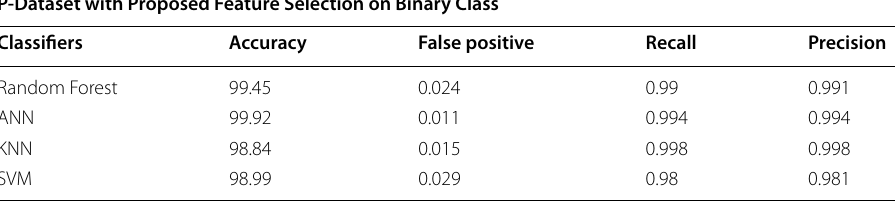
Table 11 Results of proposed feature selection on P- dataset P‑Dataset with Proposed Feature Selection on Binary